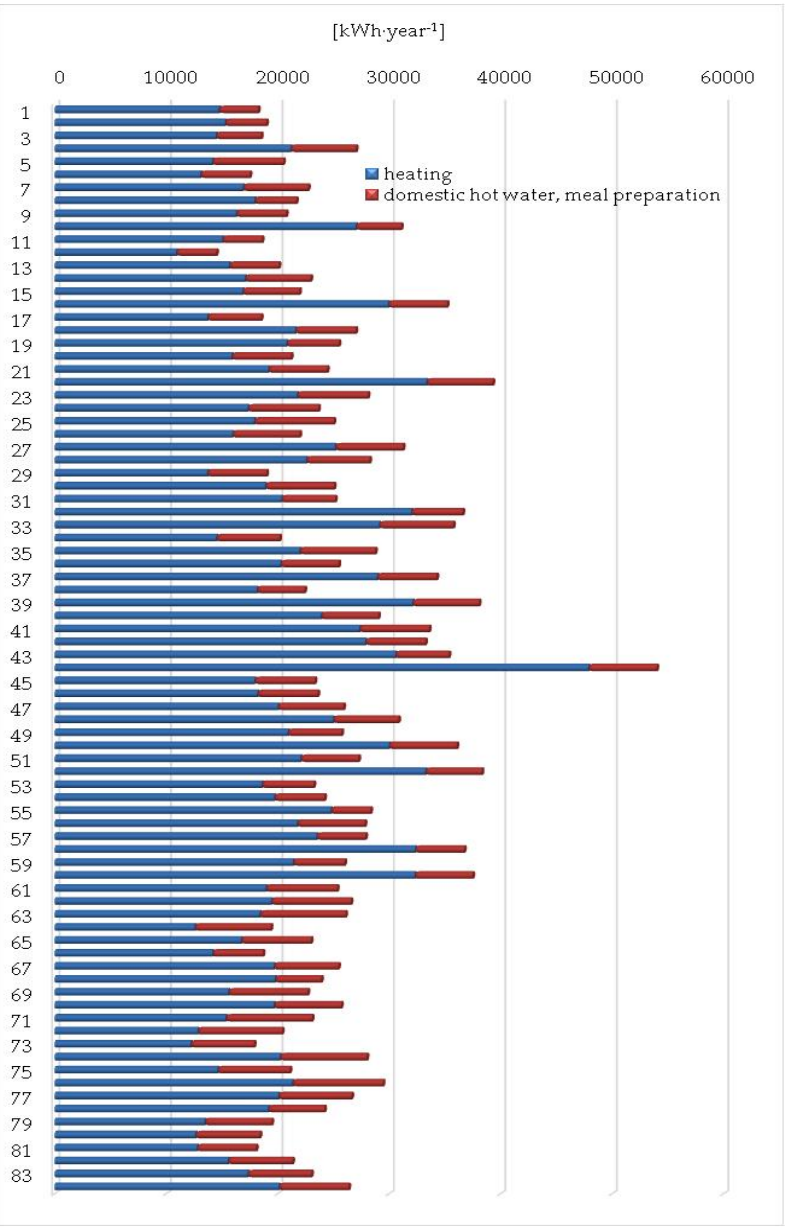
Figure 4. Summary of energy consumption for heating and hot water preparation for the analyzed group of buildings. Table 4. Values of the correction factor depending on the age of the